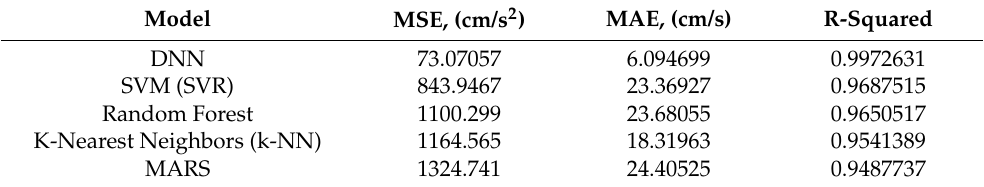
Figure 4. Prediction densities by multiple machine learning algorithms. Table 1. Comparison of machine learning algorithms (values calculated against testing set).